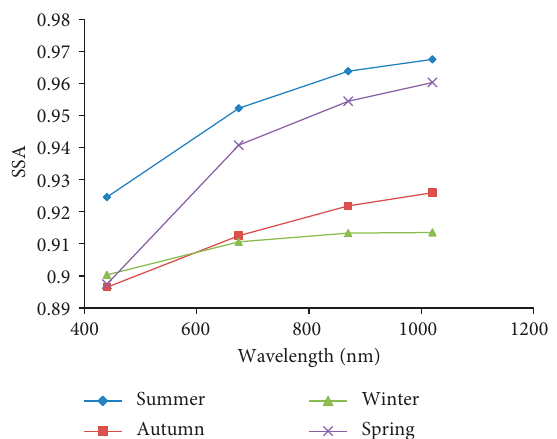
Figure 7: Variations in seasonal averaged SSA with respect to wavelength over Karachi during September 2006–August